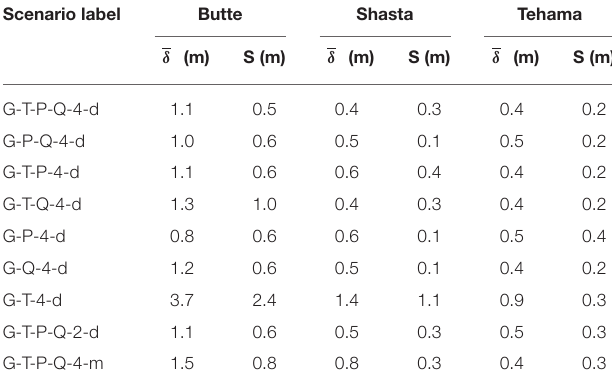
TABLE 3 | MLP predictive performance at all three sites and for nine scenarios. Scenario label